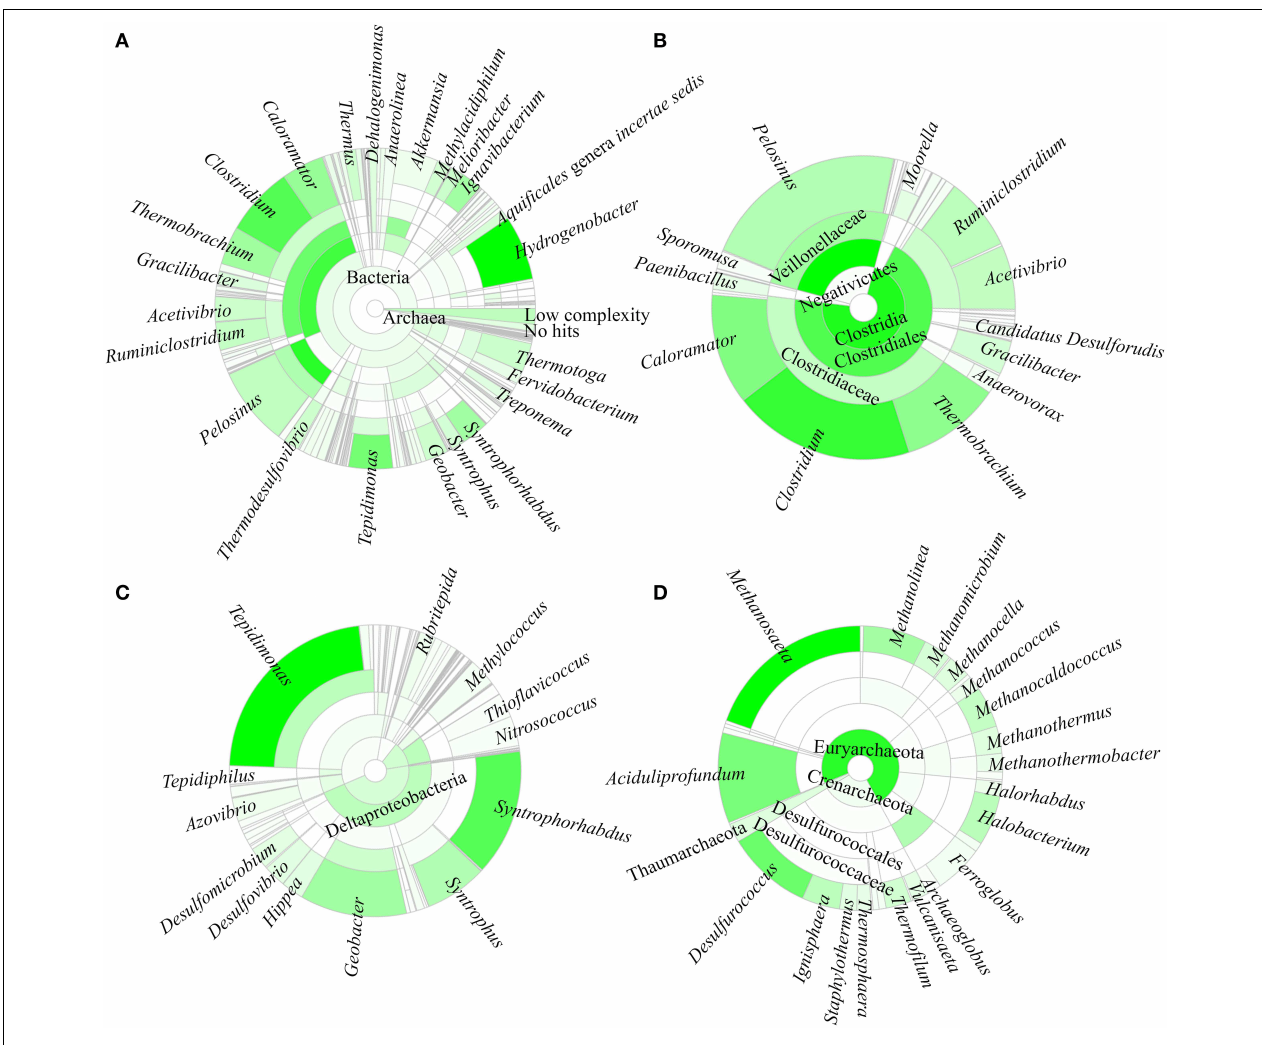
FIGURE 3 | Taxonomic affiliation of 16S rRNA metagenomic fragments. The phylogenetic distribution for (A) the overall population, (B) Firmicutes, (C) Proteobacteria, and (D)